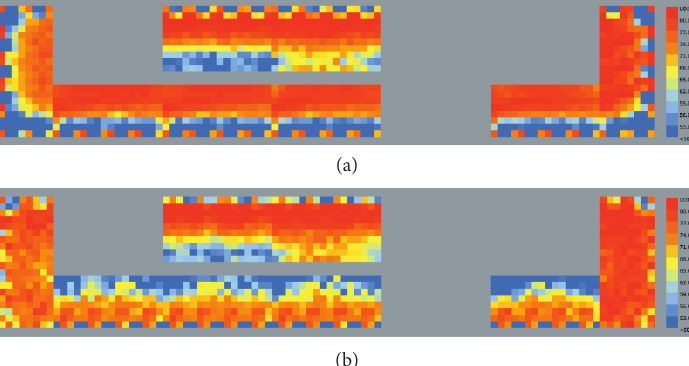
Figure 12: Visualization of UDI in the 7th floor office area before and after optimization. (a) UDI of initial solution and (b) UDI of Option 1.